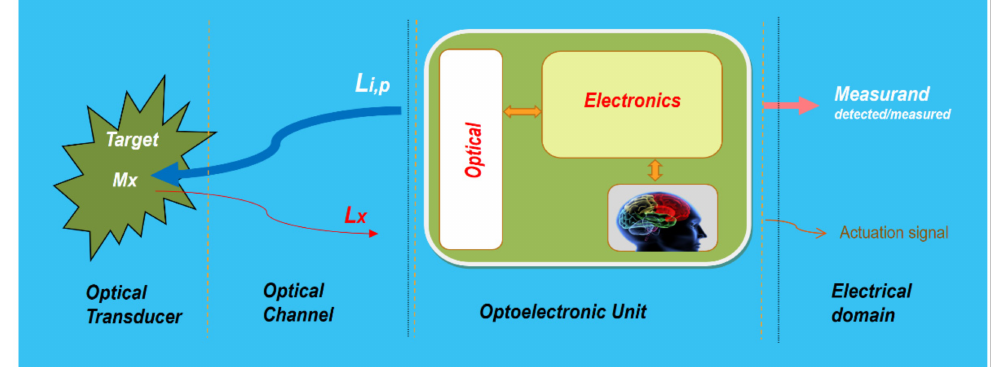
Figure 4. Illustration of the photonic sensor concept and its block diagram. The photonic sensor provides representative and faithful electrical signals of the measurands on/in a given object or target. When a PS is equipped with intelligence and provides actuation signals, it is transformed into a Smart Photonic Sensor (SPS). It is integrated into three main parts: optical transducer, optical channel, and optoelectronic unit. Courtesy of the author.